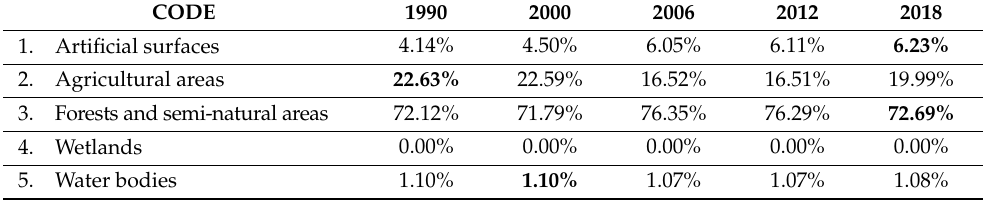
Table 6. Percentage of land-uses according to level 1 of CLC nomenclature in the Autonomous Community of the Canary